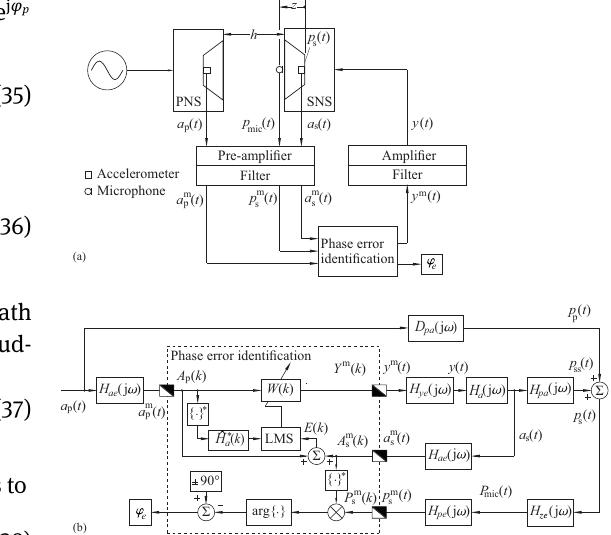
Figure 3: Phase error identification. (a) setup, (b) corresponding block